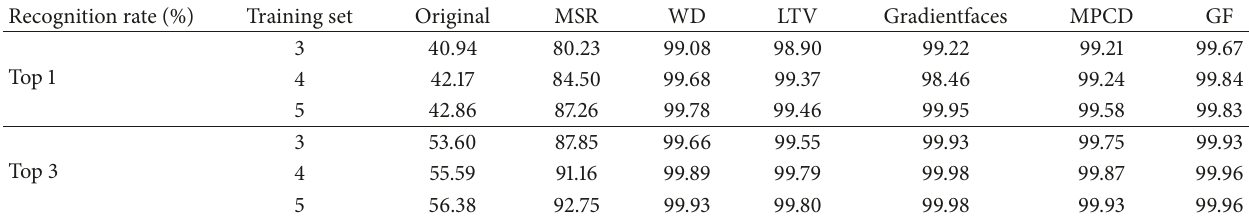
Table 2: Comparison on the recognition rate of different illumination invariants in Section 2.